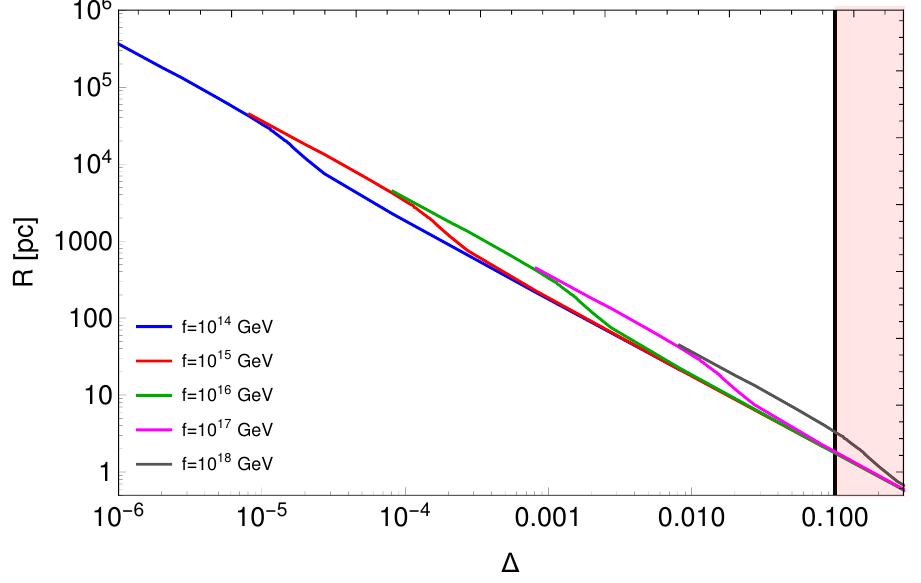
Figure 2 . The allowed radii for condensates of axion particles in FDM, as a function of the binding energy parameter (cid:1); these condensates constitute the cores of FDM halos. Axion condensates in the shaded region are unstable to decay to relativistic axions with a very short lifetime. Here we have used the model parameters m = 10 (cid:0) 22 eV, and f in the range between 10 14 and 10 18 GeV; increasing the particle mass m merely shifts these curves down proportionally to 1 =m